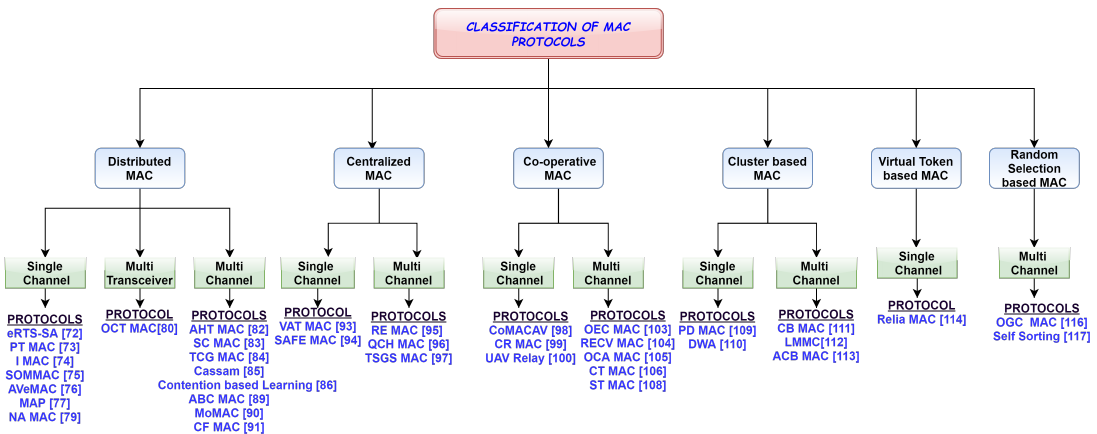
Figure 3. Classification of MAC